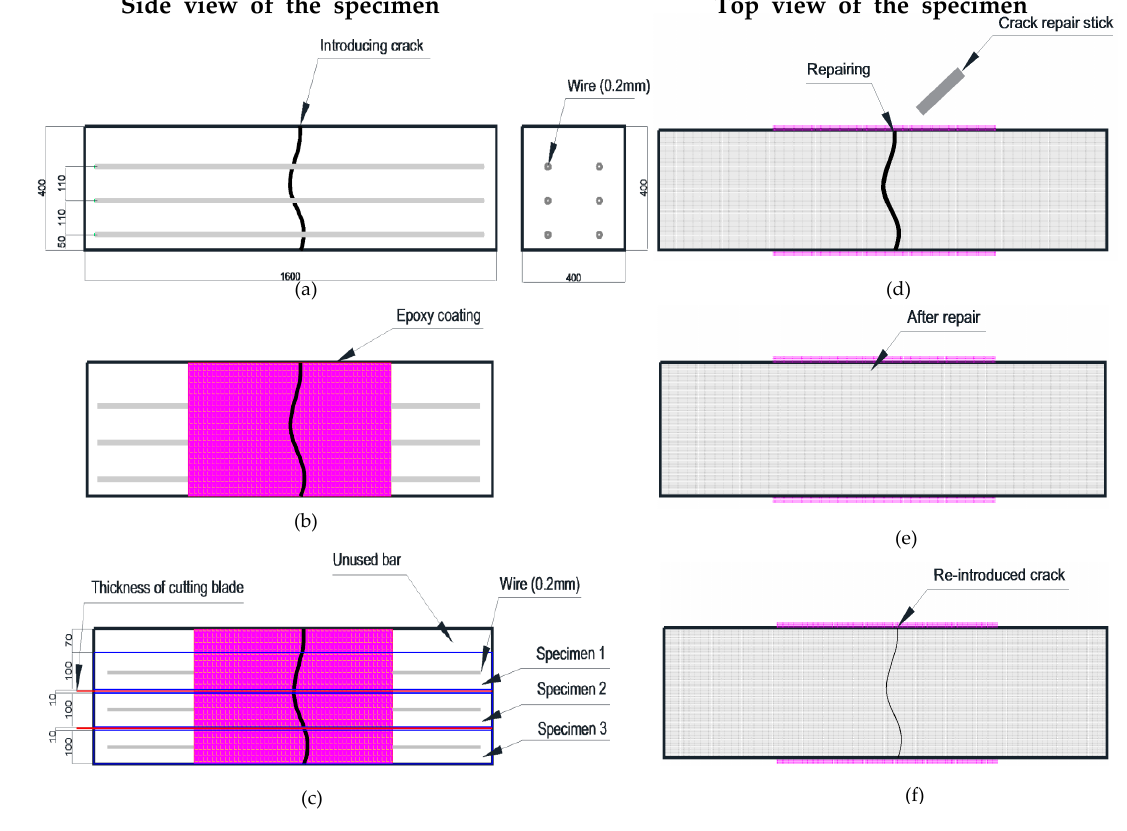
Figure 2. Work process of manufacturing specimens: ( a ) introducing crack; ( b ) covering epoxy at the side of the specimen; ( c ) cutting specimen in 10 mm thickness; ( d ) repairing a crack’s surface with crack repair stick; ( e ) after repairing crack; ( f ) re-introducing crack and then supplying water. (Unit: mm).